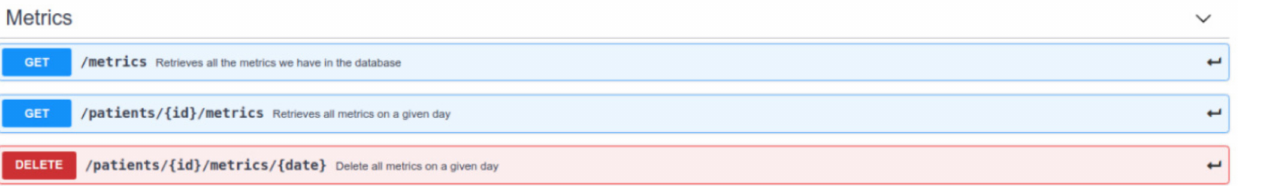
Figure 4. Excerpt of the swagger documentation of the HRV